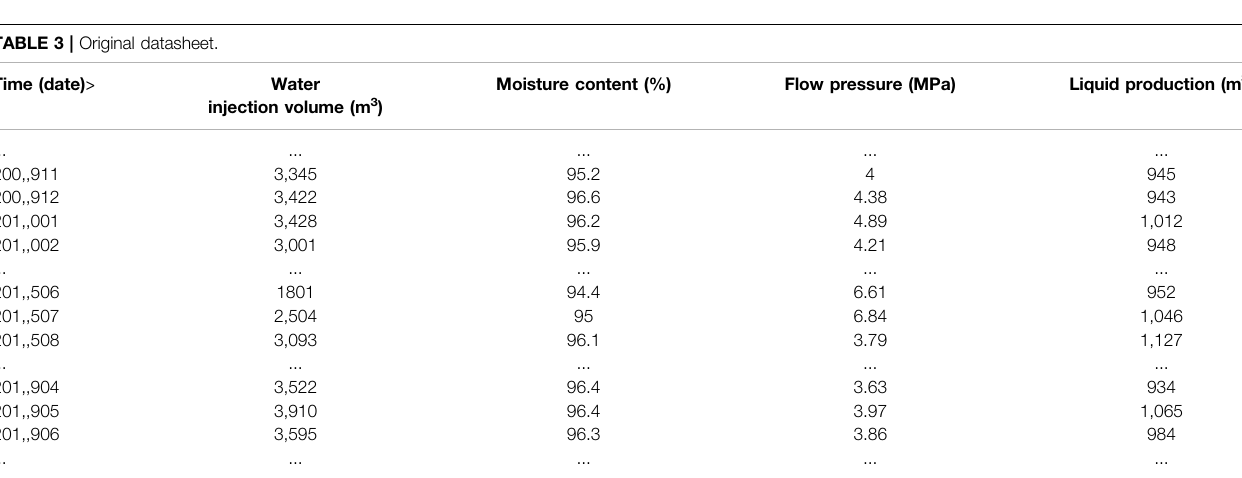
TABLE 3 | Original